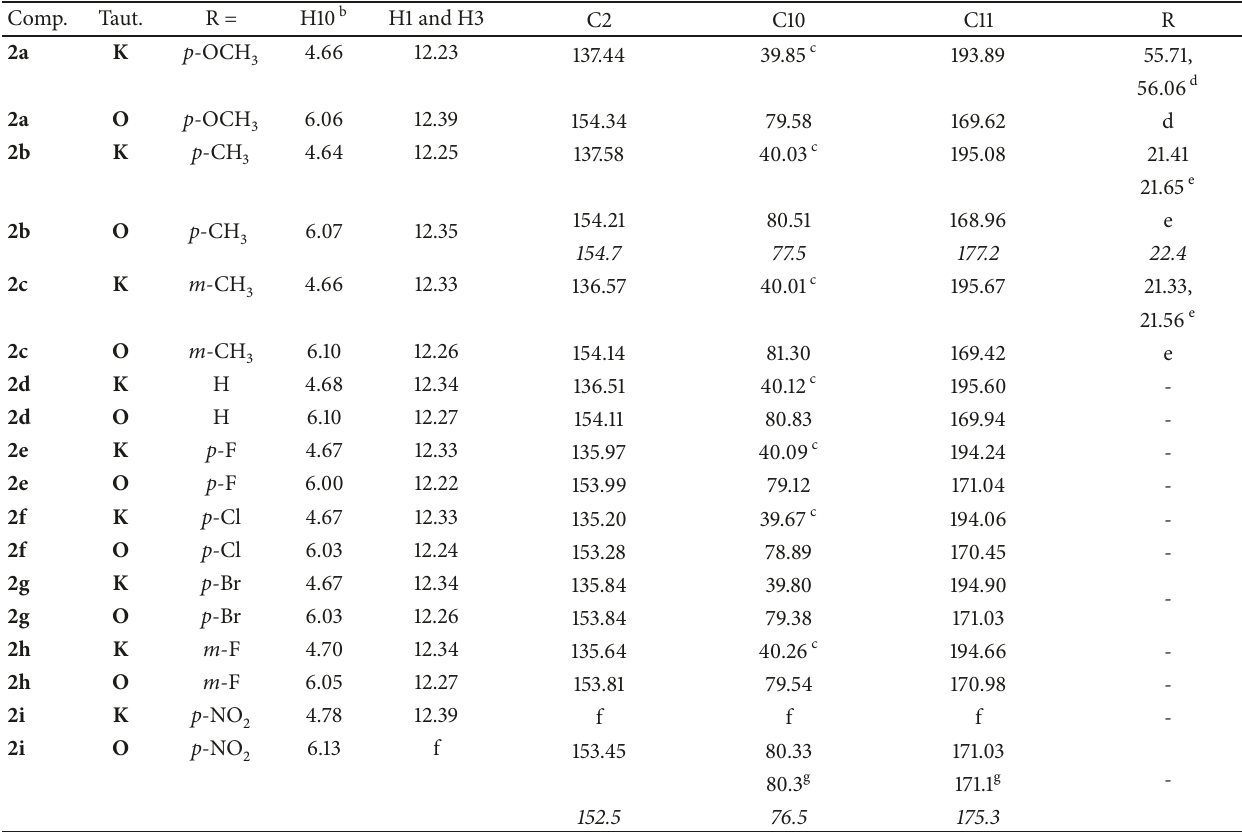
, regular characters) and 13 C CPMAS spectral data 6